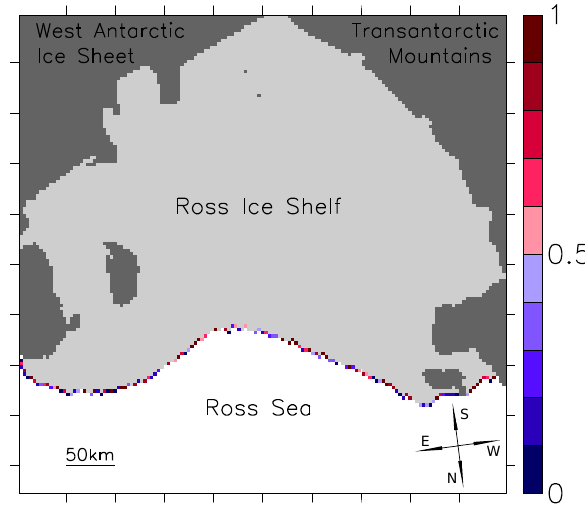
Fig. 8. Realistic steady-state model simulation of Ross Ice shelf (light gray) with grounded parts (dark gray) and the ice-free ocean (white). Values of R at the propagating ice shelf front are colored. Fig. 8. Snapshot of a realistic steady state model simulation of Ross 26 Ice shelf (light gray) with grounded parts (dark gray) and the ice- free ocean (white). Values of R at the propagating ice shelf front are Fig. 7. Realistic steady-state model simulation of Larsen A and B Ice shelf (light gray) with grounded Fig. 7. Snapshot of a realistic steady state model simulation of parts (dark gray) and the ice-free ocean (white). Values of R at the propagating ice shelf front are colored. Larsen A and B Ice shelf (light gray) with grounded parts (dark gray) and the ice-free ocean (white). Values of R at the propagating ice shelf front are colored. 25